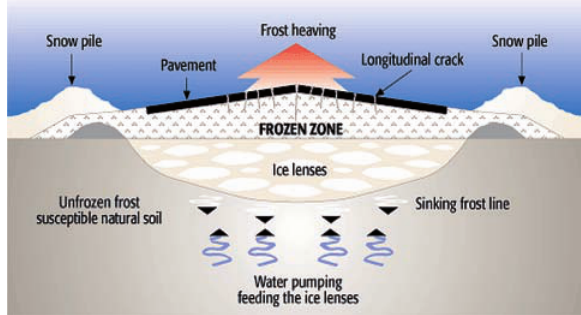
Fig. 1. The scheme of the impact of frozen ground on road structure (Tighe et al.